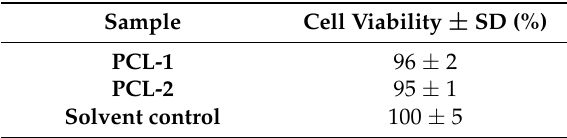
Table 3. Results of the NRU test for the highest concentrations of tested extracts (0.5 mg · mL − 1 ).